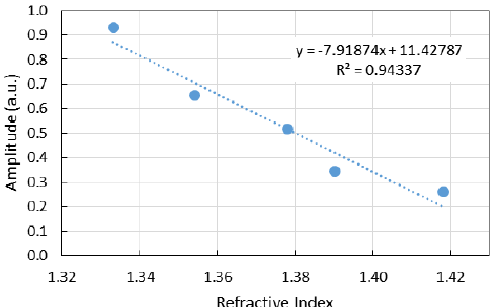
Figure 13. Calibration curve of the FP-long sensor ( L 1 = 80 µm and L 2 = 22.7 cm) using the spectral analysis restricted to Peak 2.